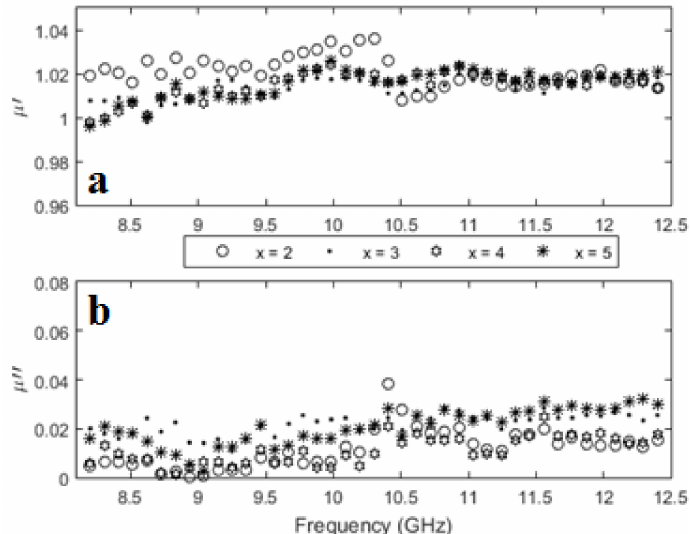
Figure 6. Frequencydependenciesofpermeability: real( a )andimaginary( b )partsforS r0.3 Ba 0.4 Pb 0.3 Fe 12 O 19 / (CuFe 2 O 4 ) x composite samples (x = 2, 3, 4 and